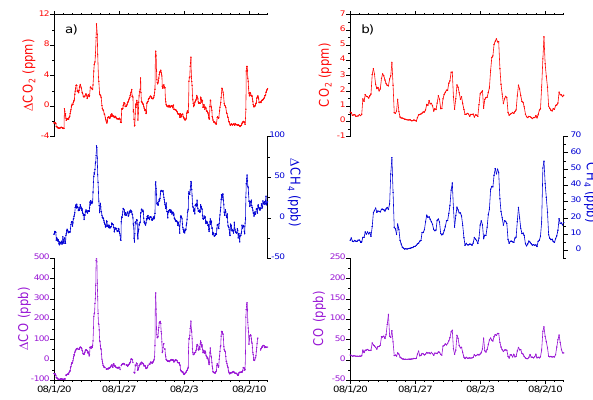
Fig. 3. Synoptic scale variations in hourly (top) CO 2 , (middle) CH 4 , and (bottom) CO based on (a) the observation and (b) the model simulation for the period from 20 January to 12 February 2008. The range of the y axis for the simulation plot for each chemical species is half of that for the corresponding observation